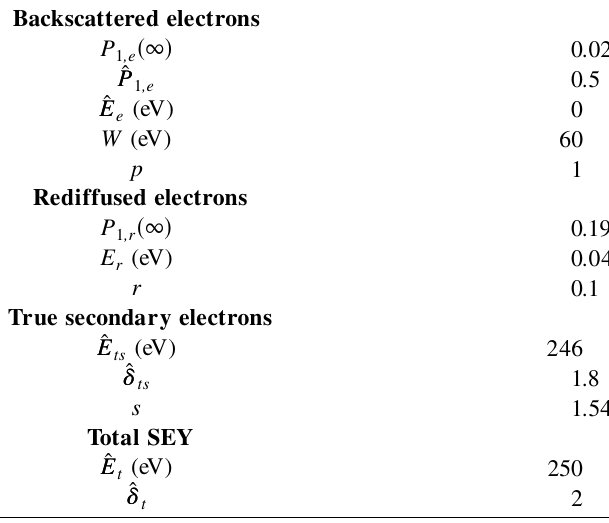
TABLE II. Main parameters of the model, typical values used for the SNS, titanium nitride coated stainless